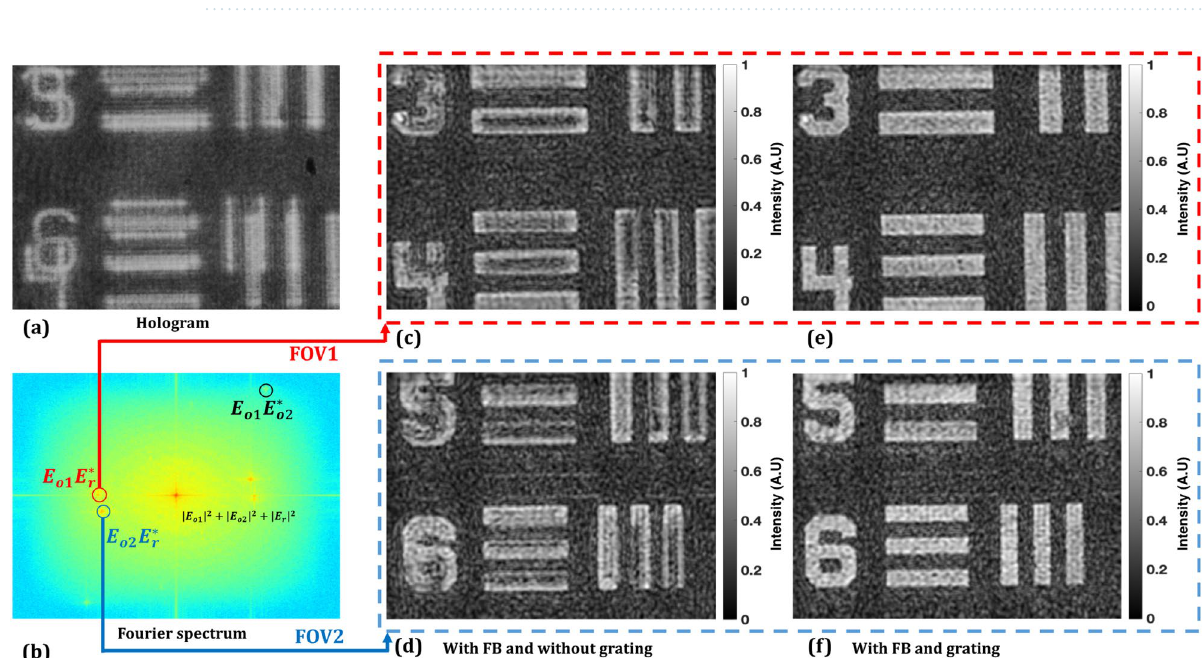
Figure 3. Experimental results of the proposed DH systems: ( a ) recorded multiplexed digital hologram, ( b ) Fourier spectrum of ( a ); ( c ) and ( d ) the amplitude reconstructed images corresponding to two FOVs E o E ∗ E ∗ ( E o r ) ; ( e ) and ( f ) are the improved reconstructed images corresponding to two FOVs when a r and 2 1 diffraction grating is used just after the